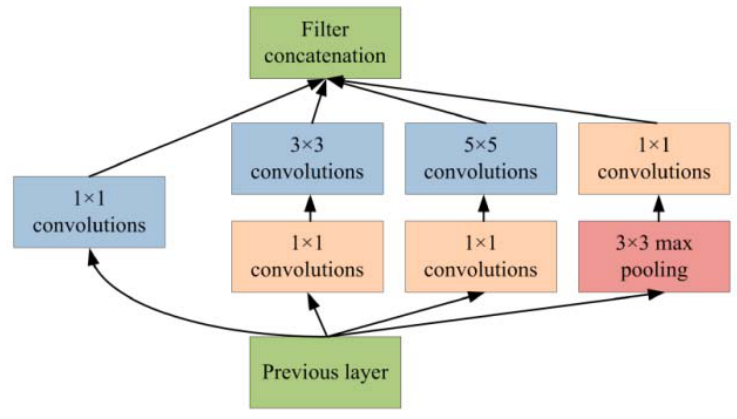
Figure 7. Inception ‐ v3 model for patch ‐ based analysis of microaneurysms. Figure 7. Inception-v3 model for patch-based analysis of